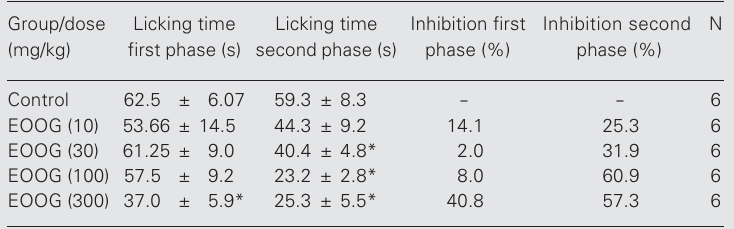
Data are reported as means ± SEM. N indicates the number of animals per group. *P<0.05 vs control (Student t